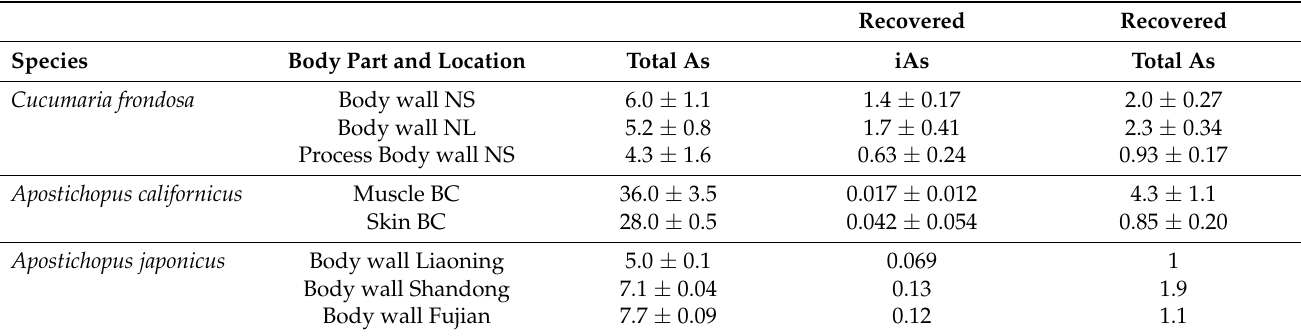
Table 3. Species, body part selected and mean total arsenic (As) and recovered inorganic arsenic